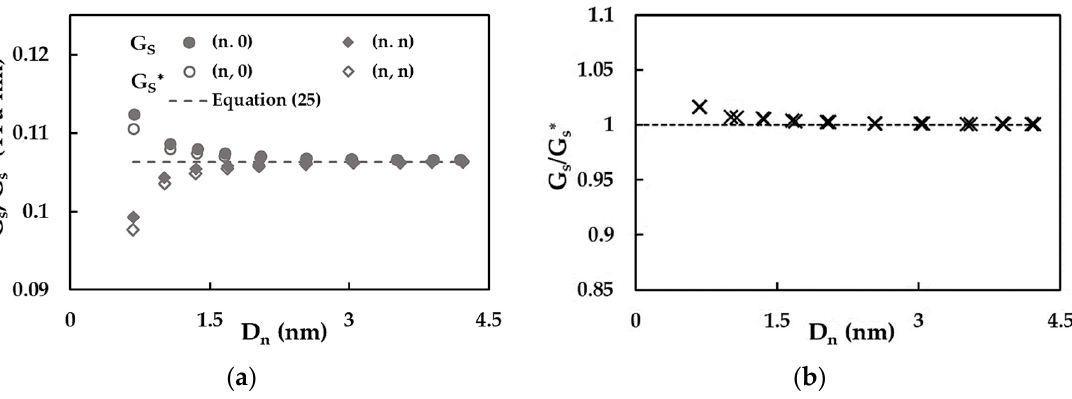
Figure 13. Evolutions of ( a ) the surface shear modulus, G S , and the reduced surface shear´s modulus, G S* , and ( b ) the ratio G S /G S* as a function of the NT diameter, D n , for zigzag and armchair SWSiCNTs (Table 2).